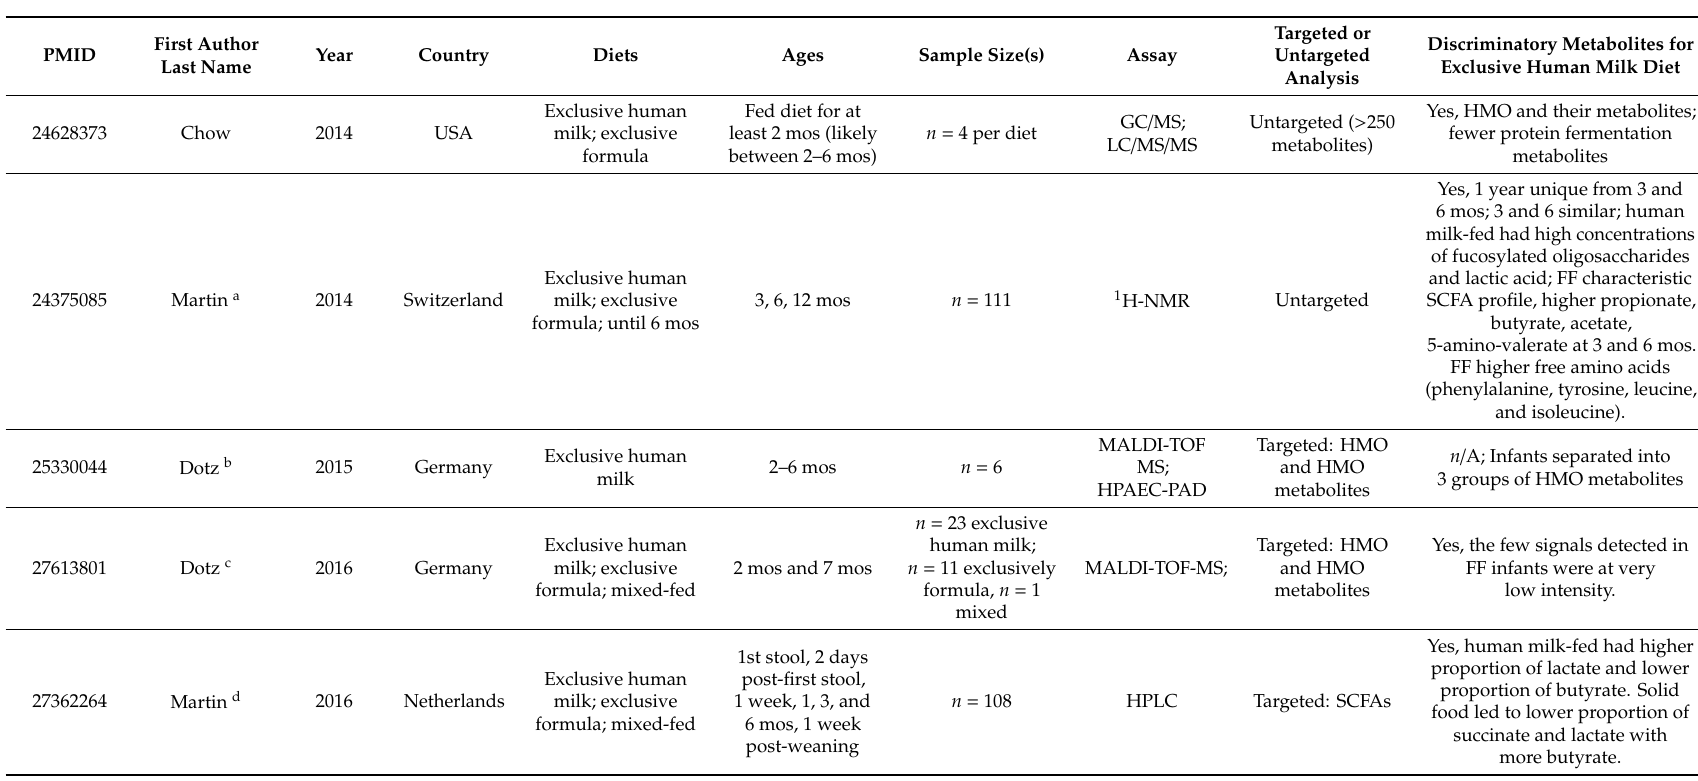
Table 1. Manuscripts reporting fecal metabolites from human milk- and / or formula-fed infants ( n =